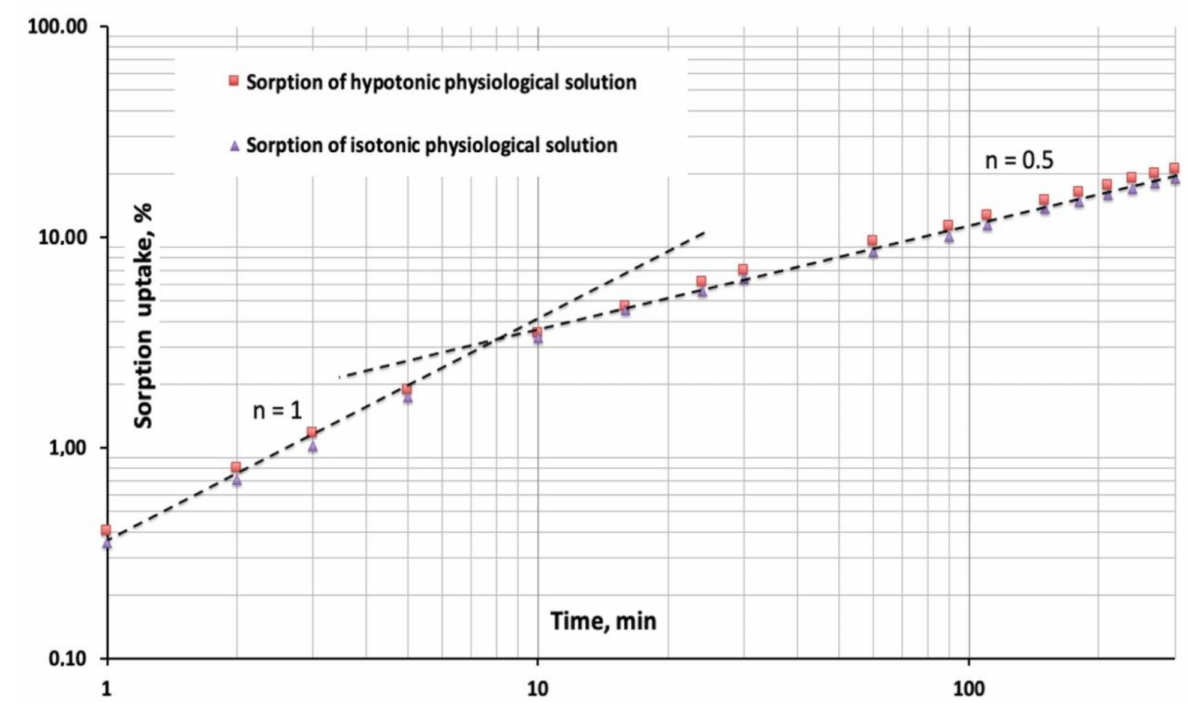
Figure 5. Early stages of the swelling process plotted in a log-log scale diagram. The slope n = 1 represents the limiting Case II sorption mode while the slope n = 0.5 represents a diffusion-controlled process (swelling front advancement) occurring during the equilibration in physiological solutions of the 5% by volume nanosilica P-HEMA hybrid